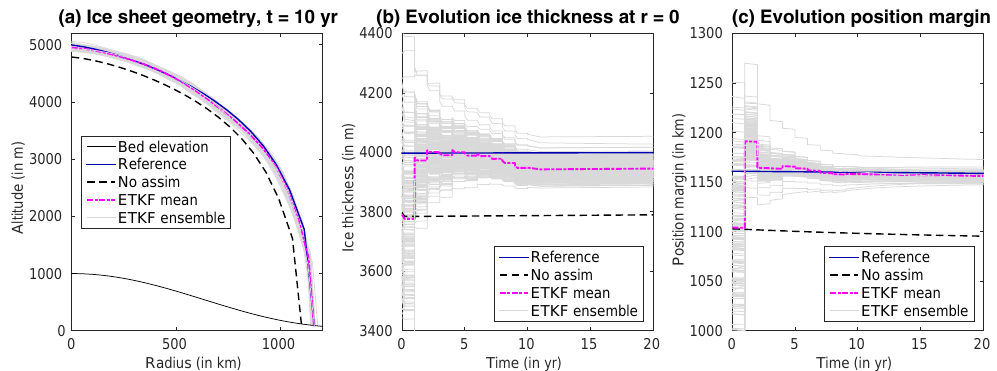
Figure 13. ETKF results for the advanced configuration where observations of surface elevation are assimilated over the first 10 years and a forecast is made for 10 further years. (a) ETKF analysis at time t = 10 years compared with the reference. (b) Evolution of the ice thickness at r = 0 with time. (c) Evolution of the position of the margin with time.